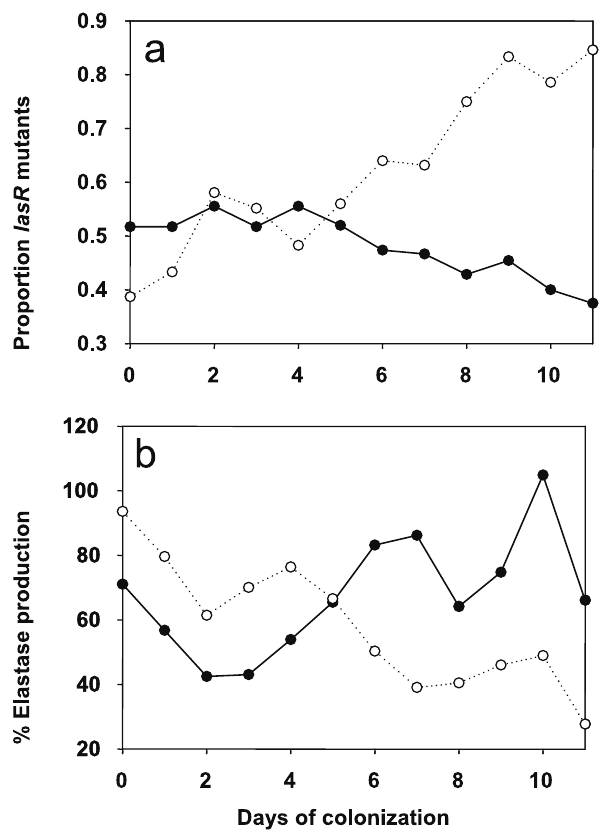
Figure 4. lasR mutant growth rates and invasion of wild type populations in the presence and absence of azithromycin. In vitro densities of wildtype (black) and lasR mutant (grey) after 72 hours growth in M9 salts BSA medium (a), and selection coefficients of lasR mutant relative to wildtype (b) as a function of azithromycin (AZM). Bars show means ( 6 SEM) of six replicates. All differences (wildtype versus lasR ) in the presence of azithromycin are statistically significant (p ,